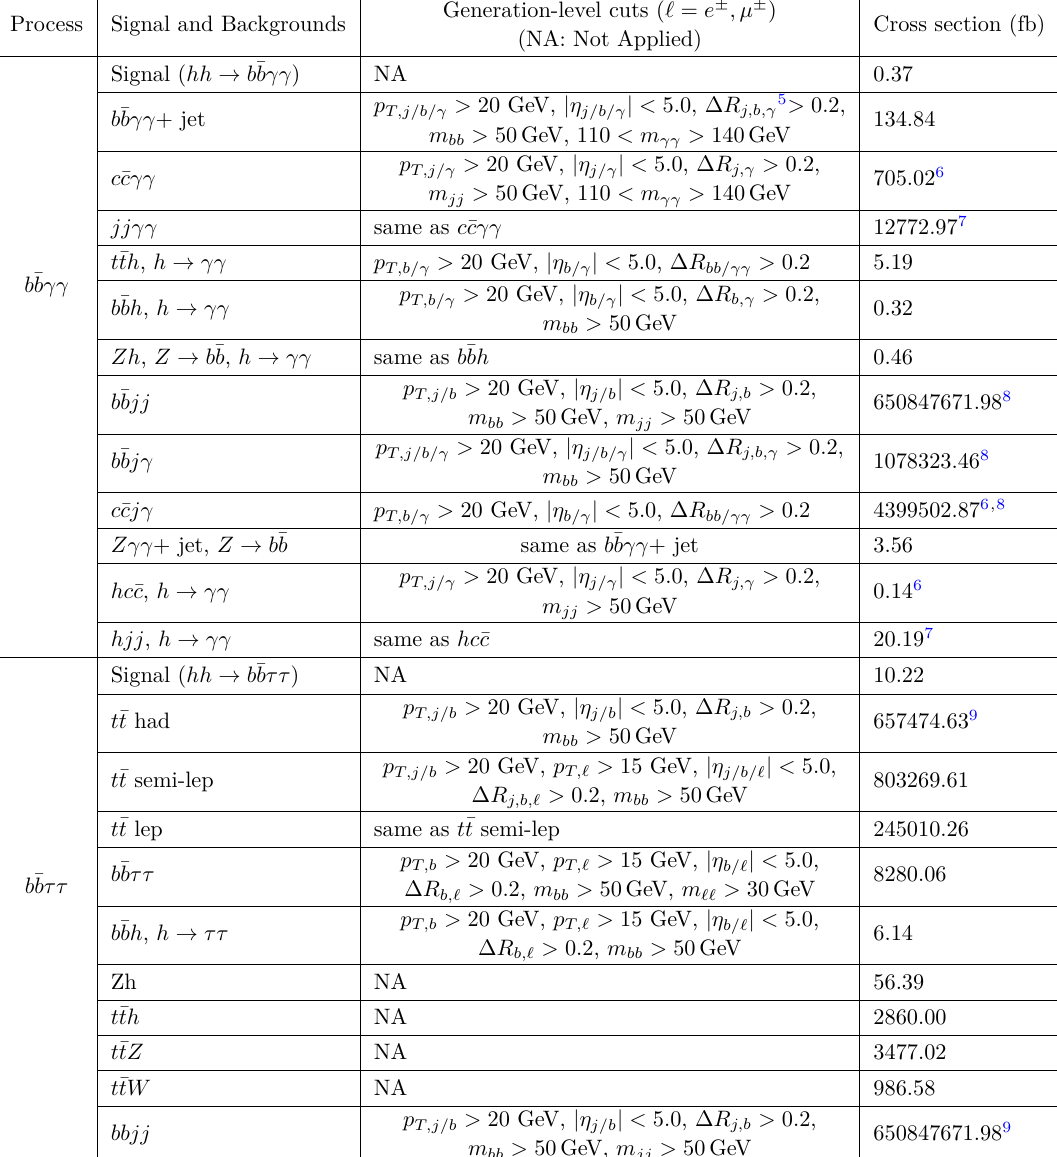
Table 11 . Generation level cuts and cross-sections for the various backgrounds used in the